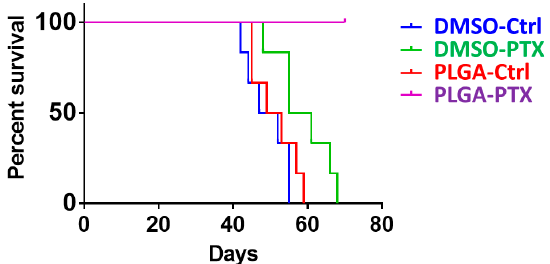
Figure 9. PLGA-PTX improved the survival rate in orthotopic xenograft tumor models. Kaplan– Meier survival analysis, beginning at 2 weeks after tumor cell injection (day 0) and